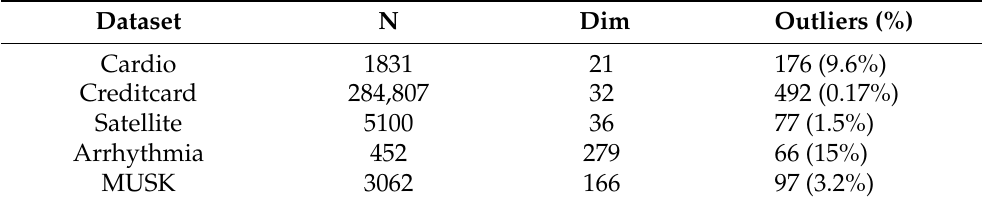
Table 1. Dataset